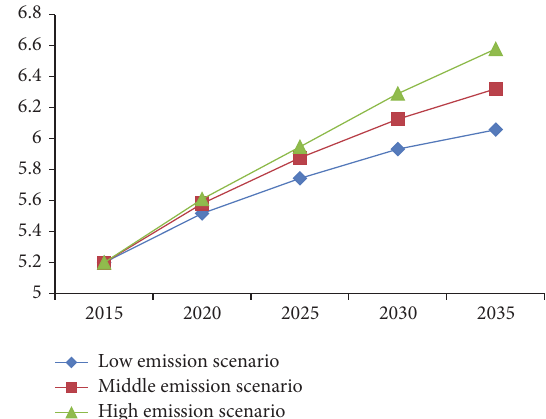
Figure 9: The trends of GDP per capita in the low, middle, and high emission scenarios (ten thousand/per person).